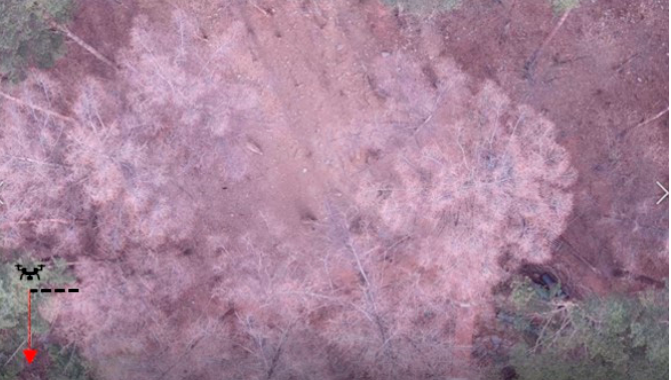
Figure 4. The monitoring screens of a portion of the whole area on November 2020 using 90 degrees angle.